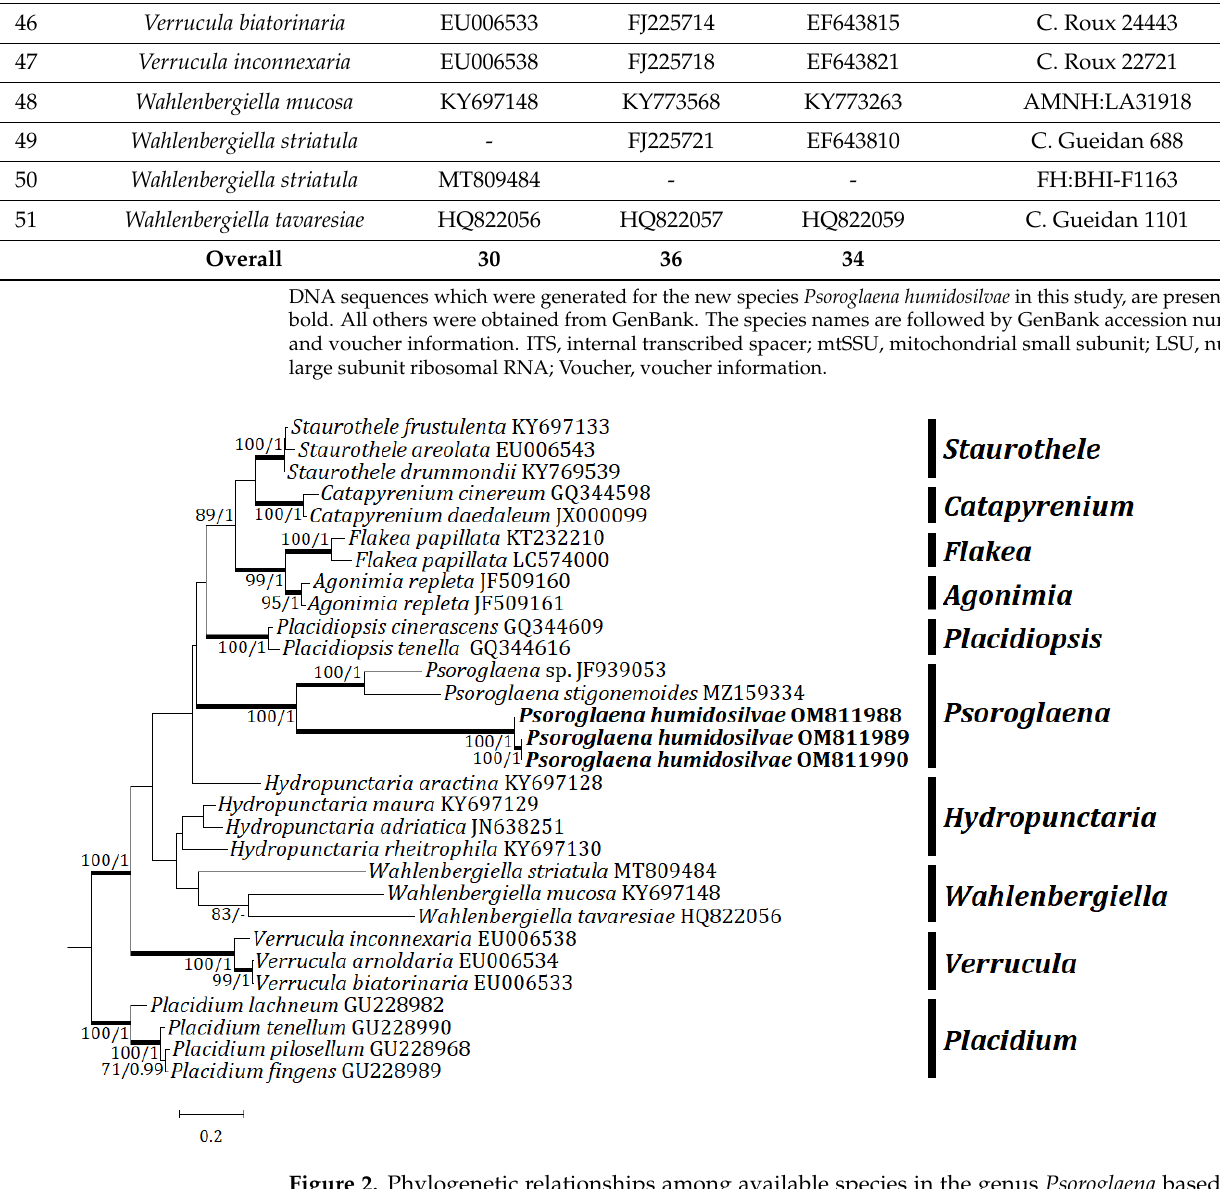
Figure 3. Phylogenetic relationships among available species in the genus Psoroglaena based on a maximum likelihood analysis of the dataset of mtSSU sequences. The tree was rooted with the se- quences of the genus Placidium based on Muggia et al. [9]. Maximum likelihood bootstrap values